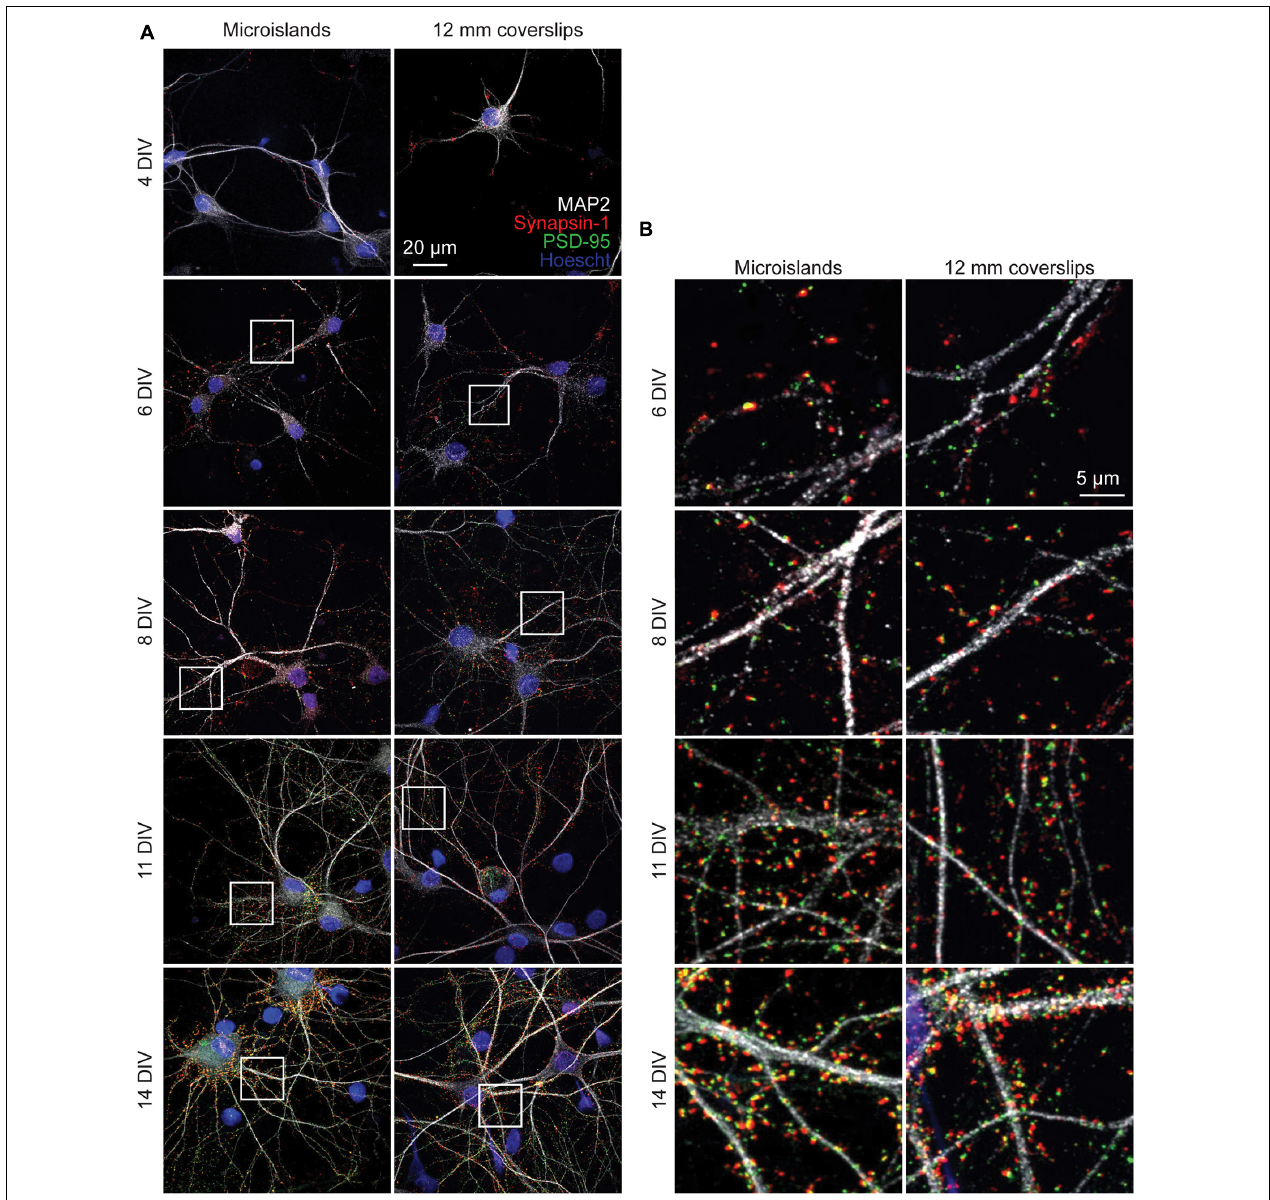
FIGURE 2 | Immunohistochemistry of microislands and bulk (12 mm coverslip) culture. (A) Confocal images of immunolabelled hippocampal cultures grown in microislands (left panels) or on 12 mm diameter coverglass (right panels) at different developmental stages (days in vitro , or DIV) as indicated. Dendrites were labeled with MAP2 (white), presynaptic terminals with Synapsin-1 (red), excitatory postsynapses with PSD-95 (green), and nuclei using Hoescht 33342 (blue). (B) Zoomed in regions to show synaptic marker localization from images in (A) where areas are indicated by white